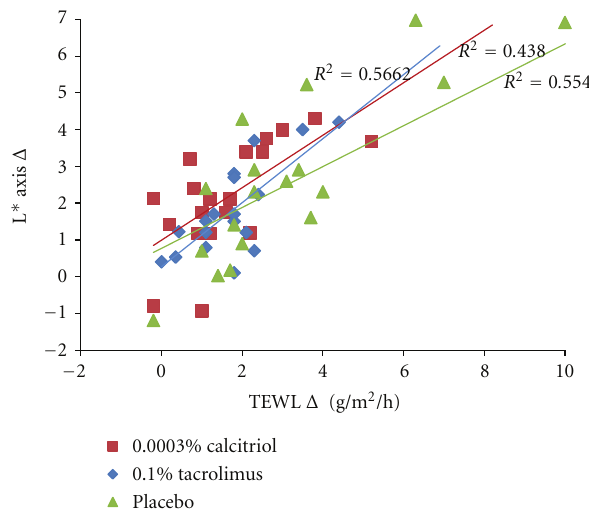
Figure 5: Relationship and regression line between the repigmen- tation of the PA a ff ected area, represented by the luminosity change (L ∗ Δ ), and the corneal stratum integrity change represented by the TEWL Δ for the three interventions. The relationship was significative ( P < 0 . 001) for all of